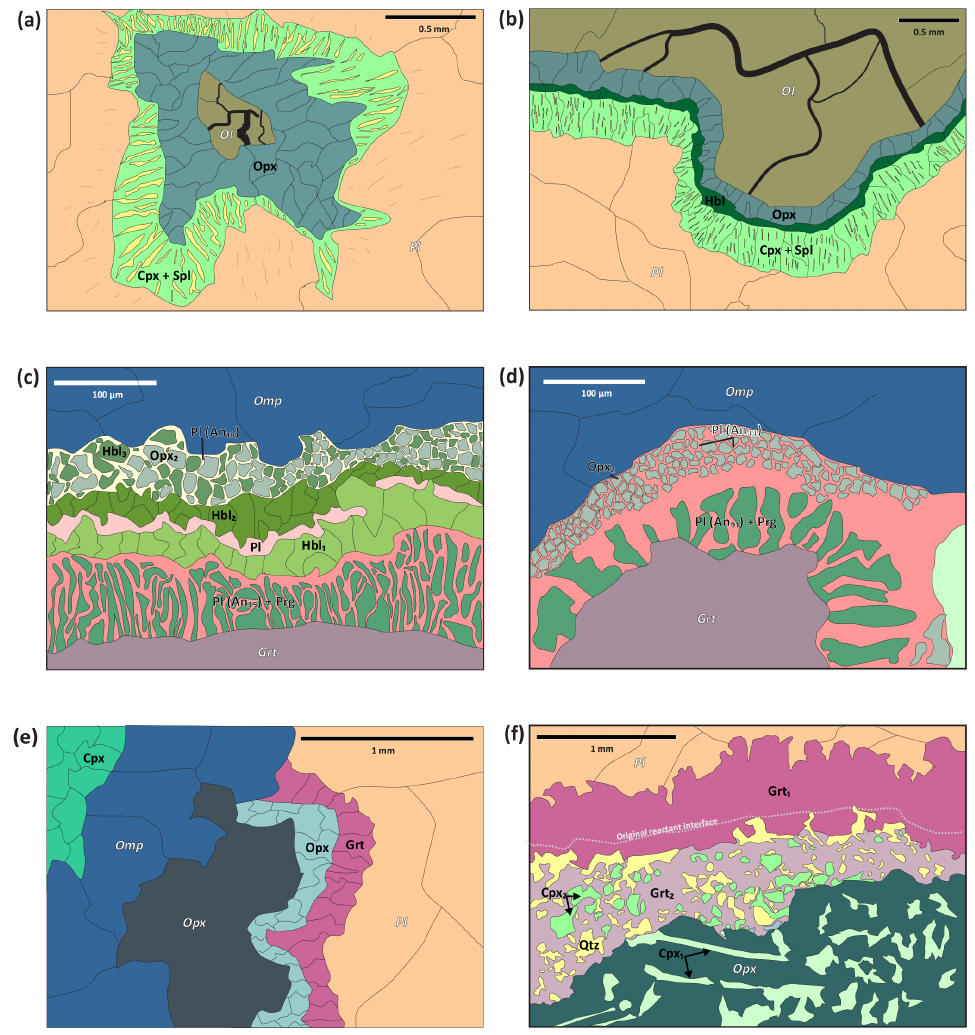
Figure 7. Common corona textures developed in mafic granulites. (a) Prograde corona developed between olivine and plagioclase during burial following shallow intrusion in the southwestern Adirondacks, New York (after Whitney and McLelland, 1973). Garnet is not present in this corona owing to low inferred pressures during corona reaction. There is no variation in X Mg of pyroxenes. (b) A retrograde corona developed between olivine and plagioclase in an olivine metagabbro from northeast Scotland (after Mongkoltip and Ashworth, 1983). The presence of amphibole suggests higher a H 2 O than in more anhydrous domainal compositions where only clinopyroxene is stable. Al content and X Fe of Opx and Hbl increase toward Pl reactant. (c) Retrograde corona developed between garnet and clinopyroxene during a static thermal event with the intrusion of numerous granite plutons in the Llano Uplift, Texas (after Carlson and Johnson, 1991). The presence of hornblende implies relatively high a H 2 O during reaction. Both hornblende and plagioclase are asymmetrically zoned across the corona band. Plagioclase becomes less calcic (An 35 to An 18 ) and amphibole Fe / Mg and Al / Si ratios decrease toward omphacite. (d) Retrograde corona developed between garnet and clinopyroxene from the Snowbird tectonic zone, western Canadian Shield (after Baldwin et al., 2004). The restricted distribution of hornblende in this corona compared to that in panel (c) suggests a less hydrous bulk corona composition. Marked zonation in plagioclase occurs from An 91 adjacent garnet to An 44 at clinopyroxene margin. (e) Prograde corona developed between plagioclase and orthopyroxene during deformation-enhanced reaction in a dolerite towards a shear zone (after White and Clarke, 1997). Garnet exhibits asymmetric zonation as X Alm , X Prp and X Grs increase toward Pl. Garnet zoning diminishes toward shear zone. (f) Prograde corona developed between plagioclase and orthopyroxene in a mafic granulite from Yenisey Ridge, Siberia (after Ashworth et al., 1998). Layer 1 garnet (Grt 1 ) is zoned: Fe increases and Ca decreases ( X Grs : 0.24–0.21; X Alm : 0.54–0.60) toward layer 2. A slight compositional perturbation across layer 1 is thought to mark the initial Pl–Opx boundary. In layers 3 and 4, Ca in garnet is almost constant, with higher Fe and lower Mg than in layer 1. No systematic zonation is observed in pyroxene. Non-equilibrium thermobarometric estimates for corona formation are 740 ± 20 ◦ C and 9.5 ± 0.7kbar (Ashworth et al., 2001).